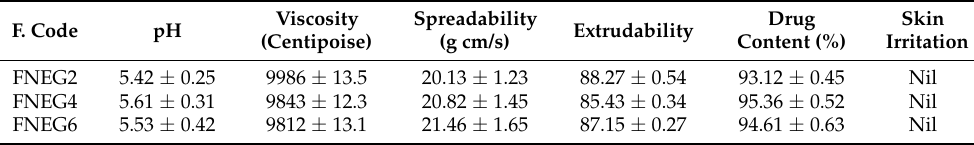
Table 4. Physicochemical characteristics of methotrexate nanoemulsion gel